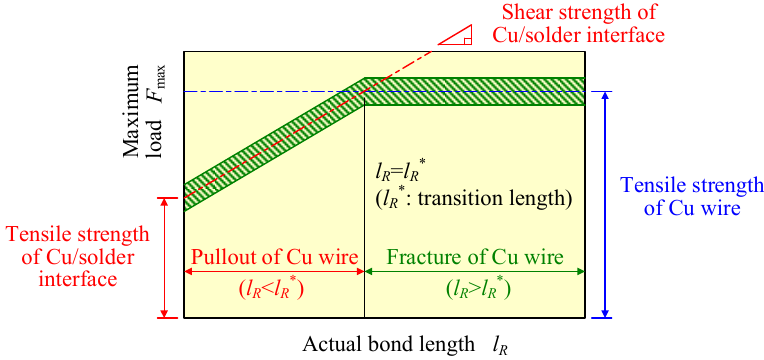
Figure 13. Tensile and shear strengths of copper/solder interface and tensile strength of copper wire in the relationship between the maximum load and actual bond length.